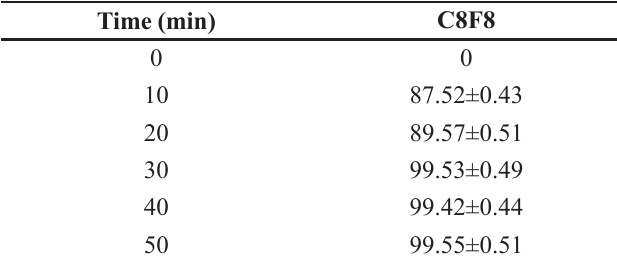
TABLE VII - Dissolution data of cefixime trihydrate in bilayer tablets